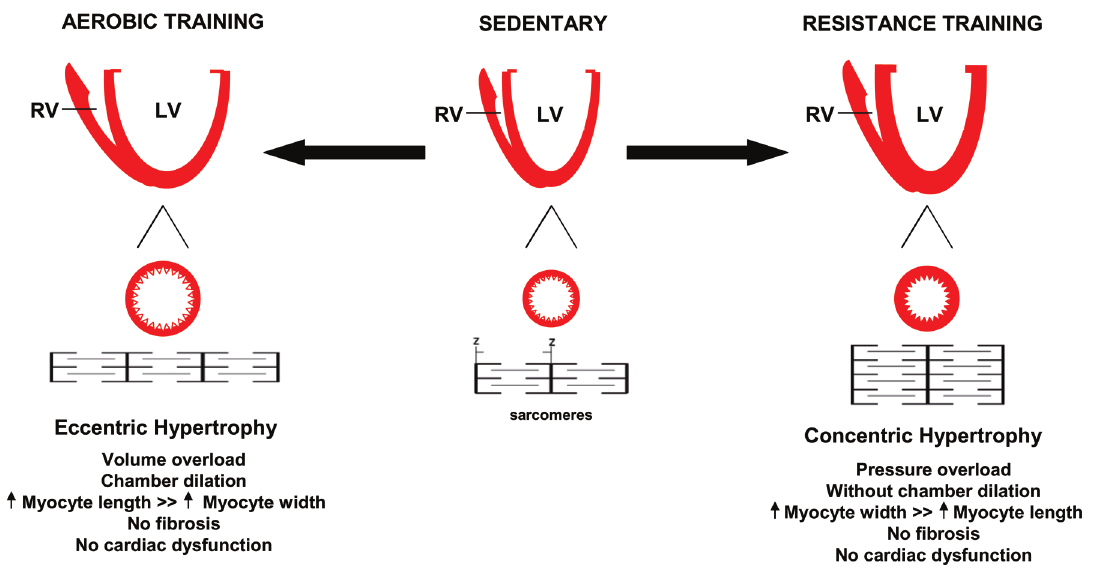
Figure 1. Effect of exercise training on cardiac hypertrophy. Physiological hypertrophy is characterized by a uniform profile of ventricular wall and septum growth, without fibrosis and cardiac dysfunction. Aerobic exercise training, such as long-distance running or swimming, is matched with an increased volume overload accompanied by cardiac chamber dilation, referred to as eccentric hypertrophy. This phenotype is associated with the addition of sarcomeres in series to lengthen the cardio- myocyte and to increase the width of the cell in parallel. In contrast, resistance training, such as weight lifting and wrestling, results in an increased pressure overload without chamber dilation, referred to as concentric hypertrophy. This phenotype is associated with the addition of sarcomeres in parallel to an increase in the cross-sectional cardiac area. LV = left ventricle; RV = right